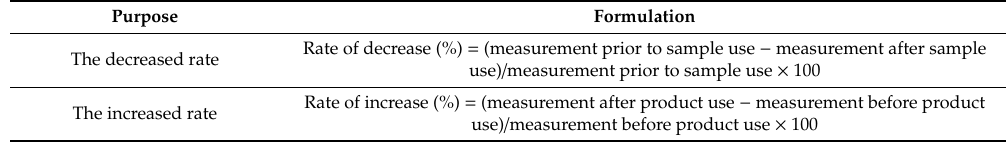
Table 1. Formulations to calculate the decreased rate and increased rate for clinical